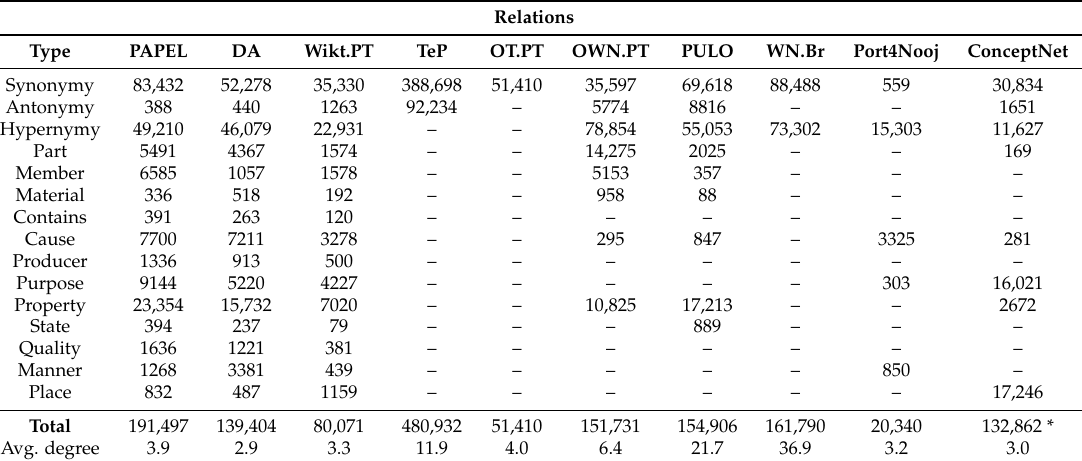
Table 3. Number of triples extracted from each